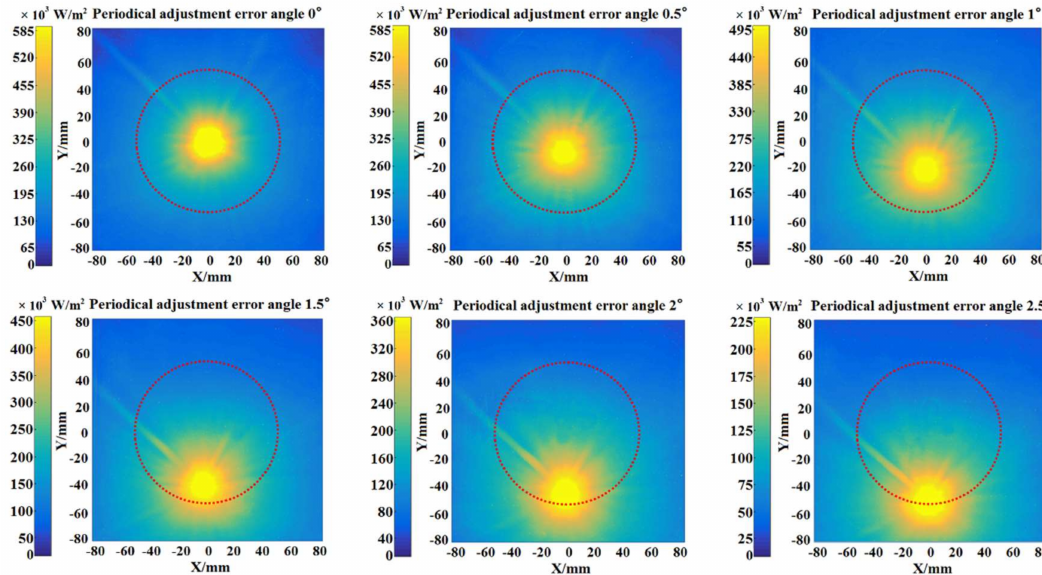
Figure 6. The flux density distributions of focal spot under different periodical adjustment error angle.